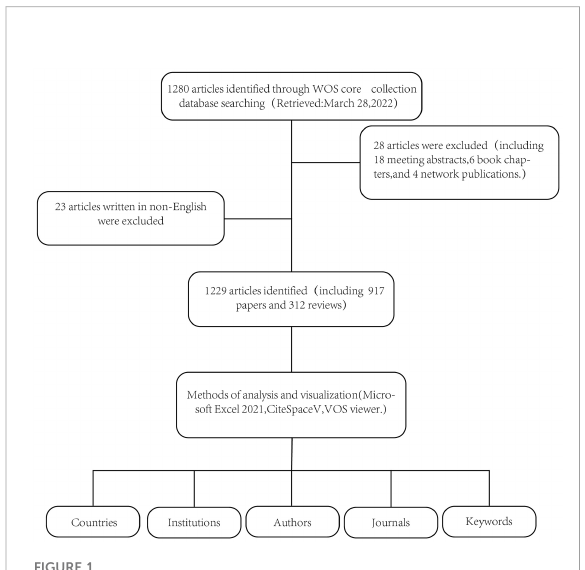
FIGURE 1 Flowchart for the selection of publications included in this